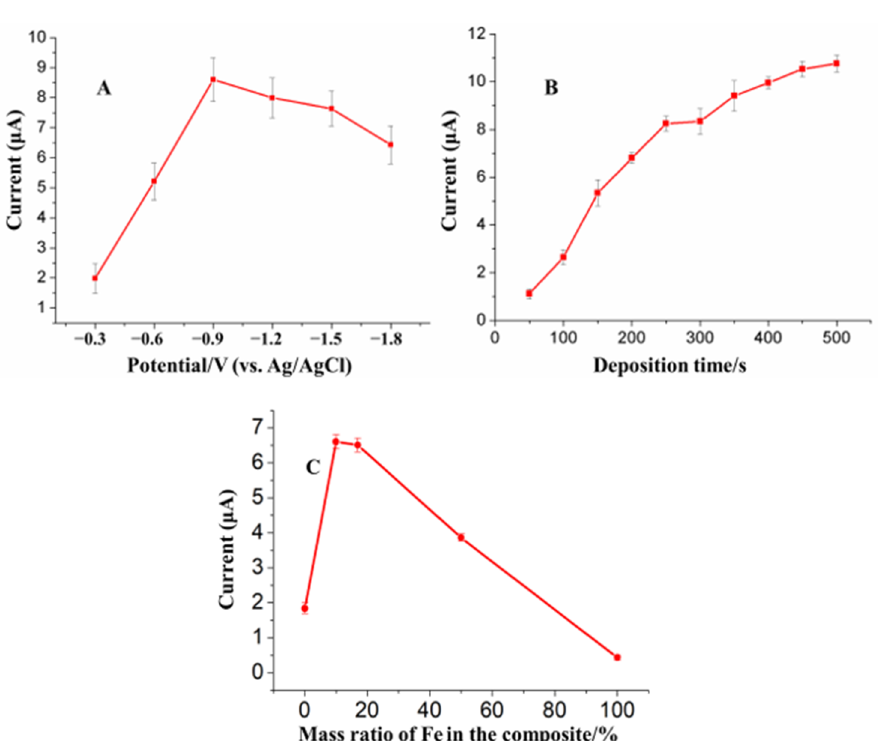
Figure 5. ( A ) Effect of the deposition potential, ( B ) deposition time and ( C ) weight ratio between Fe and Au on stripping current for 20 ppb ( A , B ) and 50 ppb ( C ) of As(III) in 0.2 M pH 5.5 acetate buffer at Fe 3 O 4 -Au-IL/GCE. Each data point is an average of 5 measurements from 3 electrodes and error bars represent ±1 standard deviation.